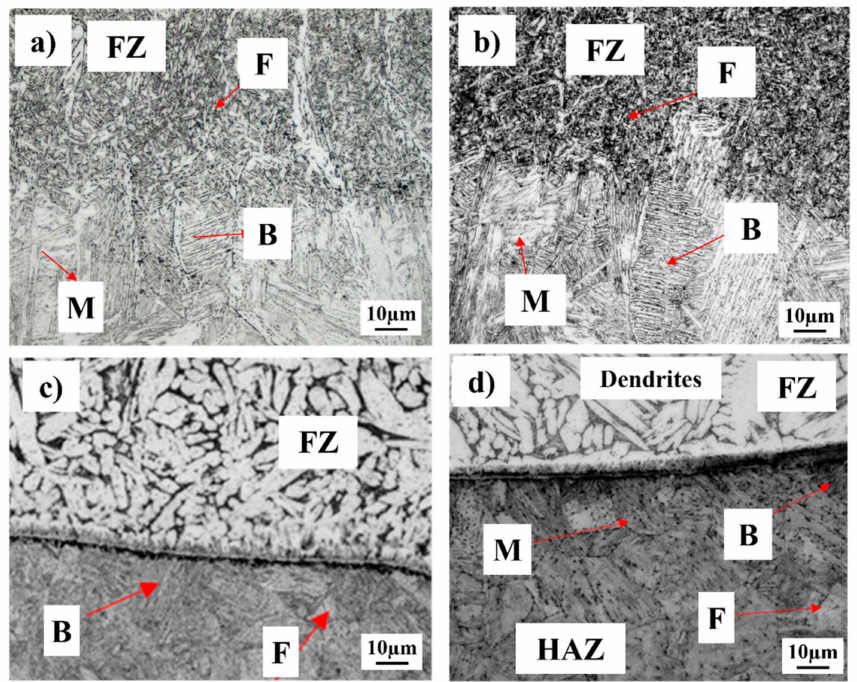
Figure 6. Microstructural features of the GMA welds: ( a ) ER80S low heat input, ( b ) ER80S high heat input, ( c ) brazing low heat input and ( d ) brazing high heat